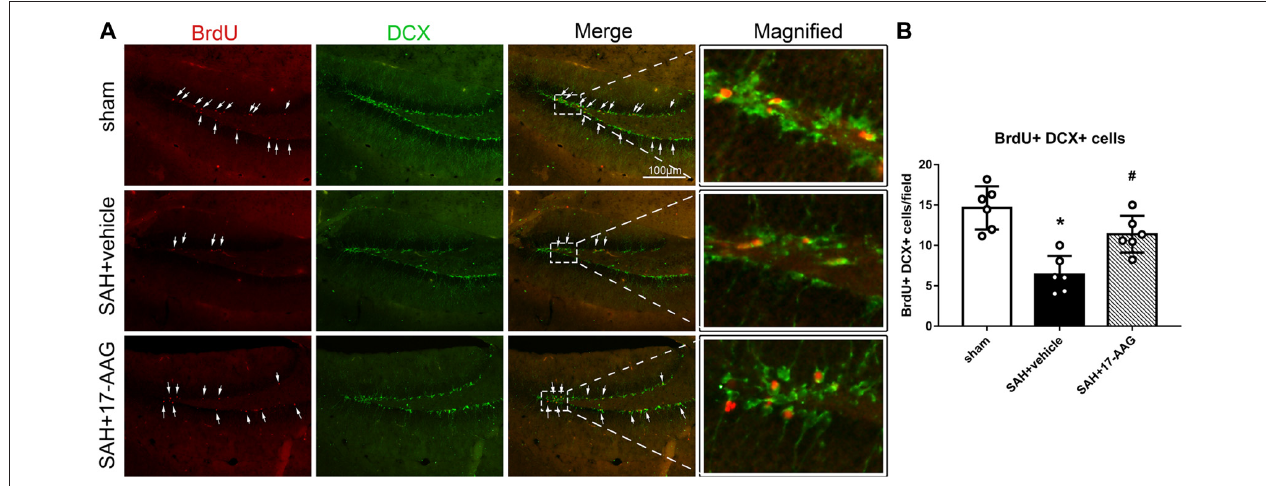
FIGURE 4 | Effects of 17-AAG on neurogenesis 4 weeks after SAH. (A) Double immunofluorescence staining and (B) Quantitative analyses of BrdU + DCX + cells in the left hippocampus 4 weeks after SAH. n = 6 per group ∗ P < 0.05 vs. sham group; # P < 0.05 vs. SAH + vehicle group. The error bars represent